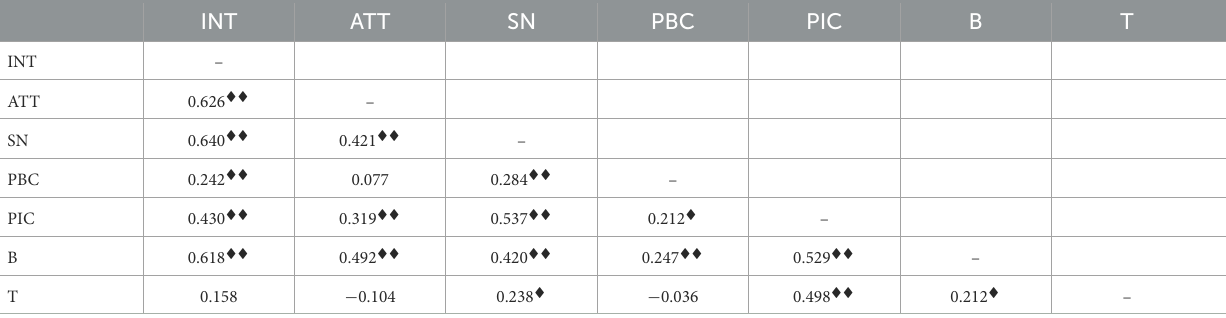
TABLE 3 Correlation matrix ∗